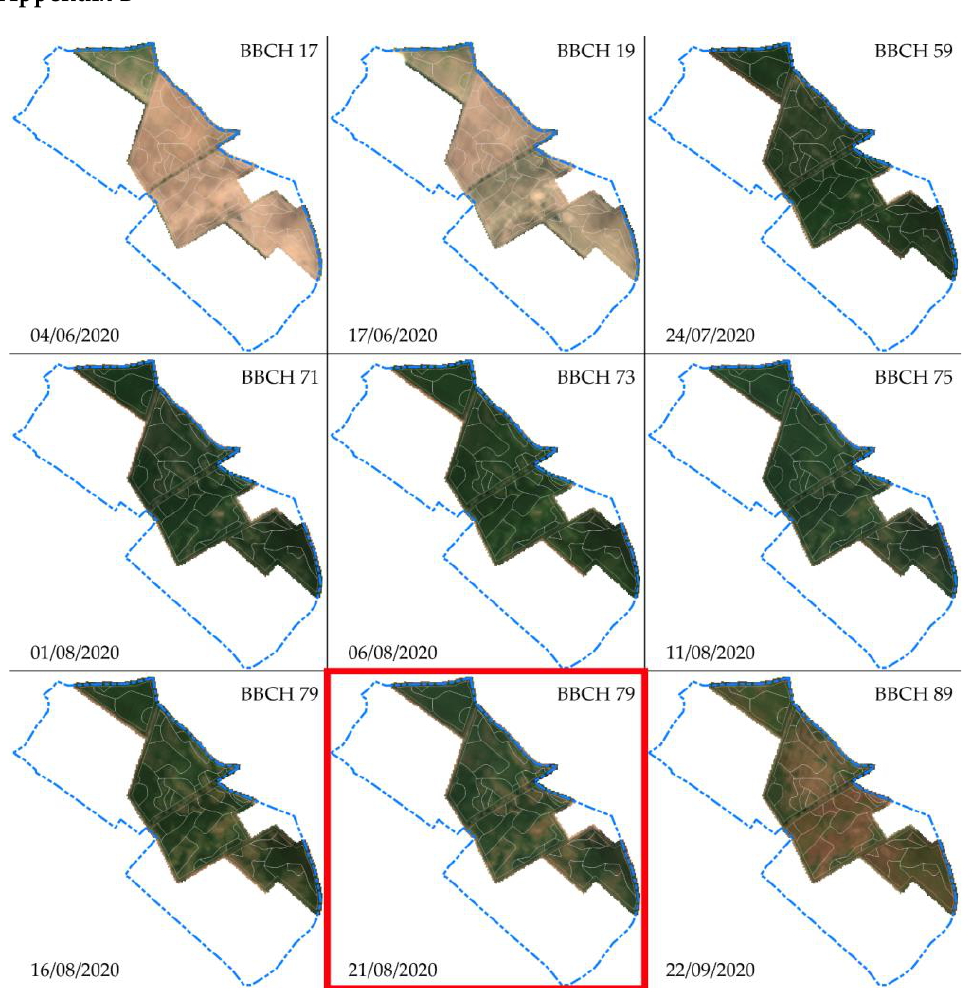
Figure A1. Database of Sentinel-2 images for the maize growing season (BBCH 1 – BBCH 8).